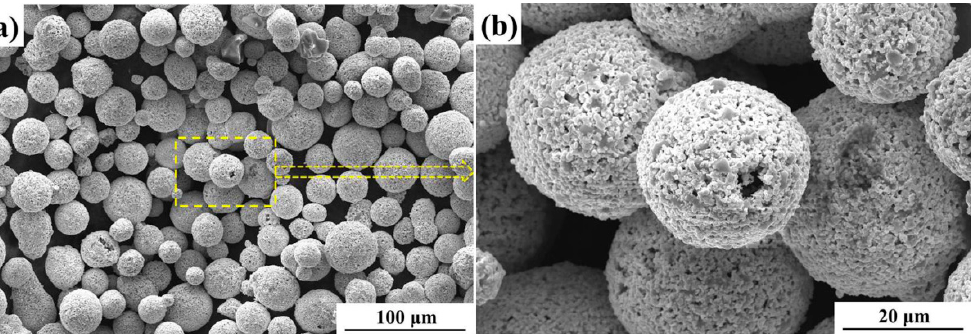
Figure 1. FE-SEM micrographs of the feedstock powder: ( a ) typical surface morphology; ( b ) a magnification of the rectangular frame in ( a ).